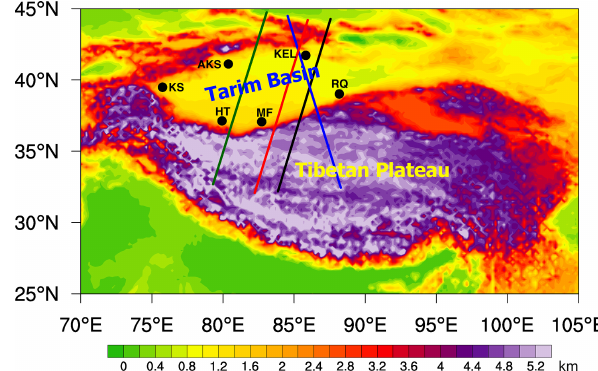
Figure 1. Topographical map of the study domain and distribution of the stations in the Tarim Basin (TB). The contours of the terrain height are in kilometers above mean sea level (kma . m . s . l . ). The solid lines indicate the trajectory of the CALIPSO satellite over the TB on 4 July (20:22UTC; black line), 5 July (07:02UTC; red line), 25 July (20:40UTC; blue line), and 27 July (20:28UTC; green line) 2016, of which 4 and 5 July were characterized by dusty weather, while 25 and 27 July were clear